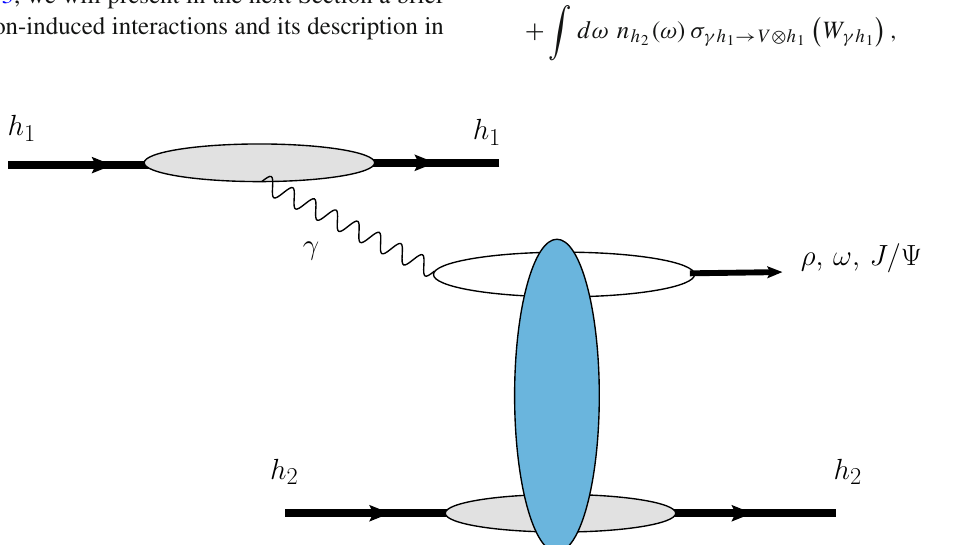
Fig. 1 Vector meson photoproduction in a hadronic h 1 h 2 collision. The vertical blue ellipse represents the strong interaction between the vector meson and the hadronic